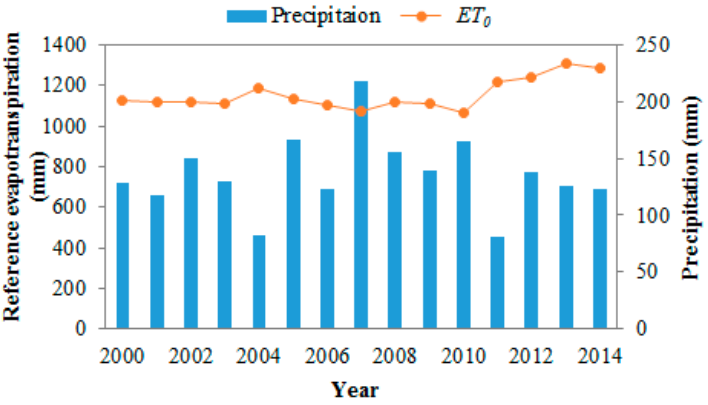
Figure 2. Annual reference evapotranspiration and precipitation in the study area during the year 2000 to 2014.